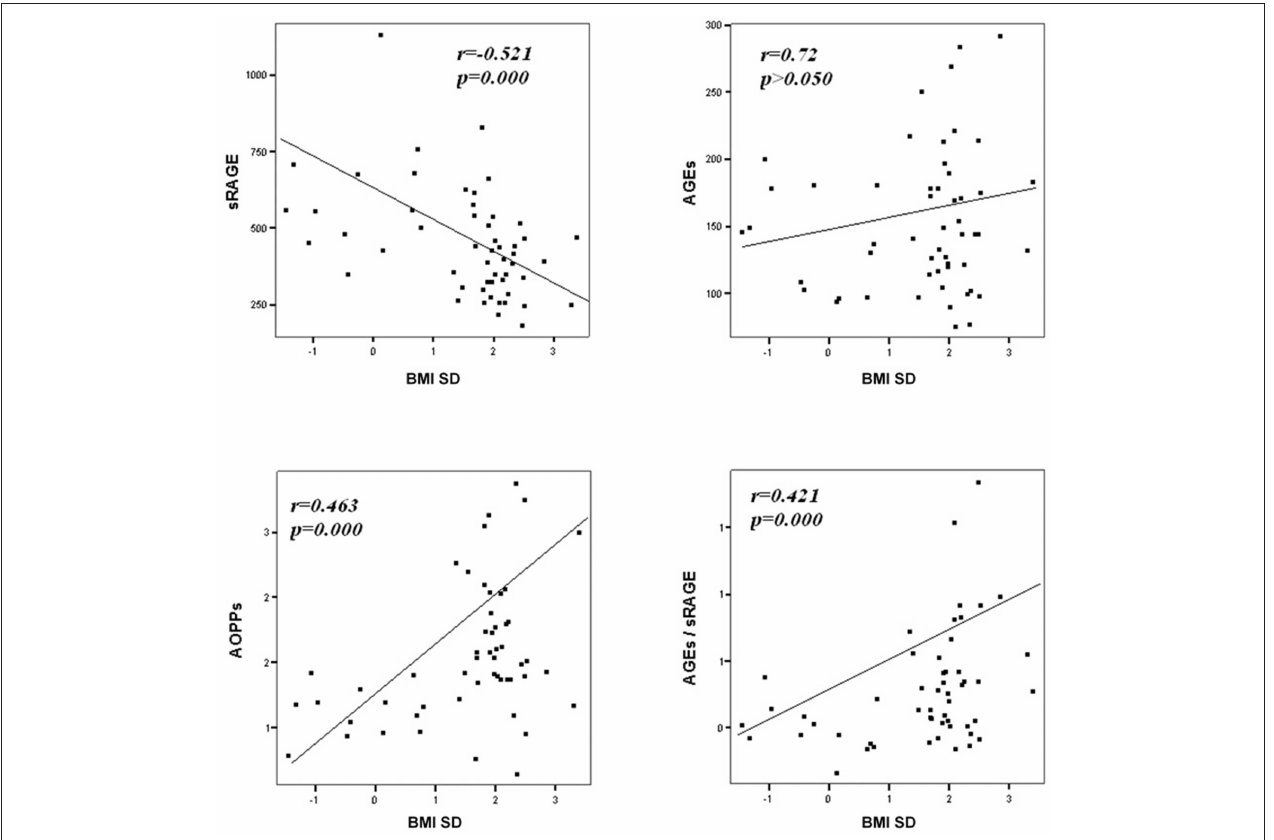
FIGURE 2 | Correlation between oxidative stress markers and BMI SD.